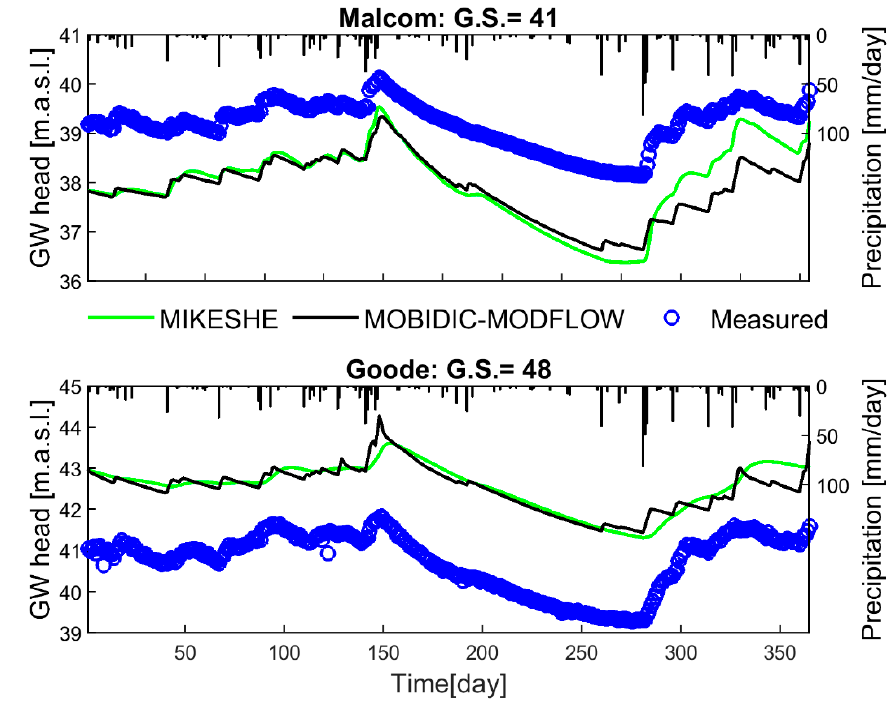
Figure 10. Measured (blue) and simulated groundwater head at Malcom and Goode (see Figure 2 for locations) with MIKE SHE (green) and MOBIDIC-MODFLOW (black), for the year 2005. G.S. is the Ground Surface elevation.